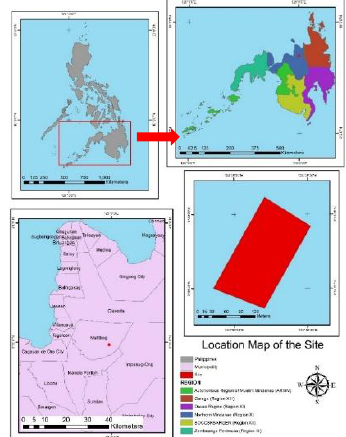
Figure 1. Location Map of the Coniferous